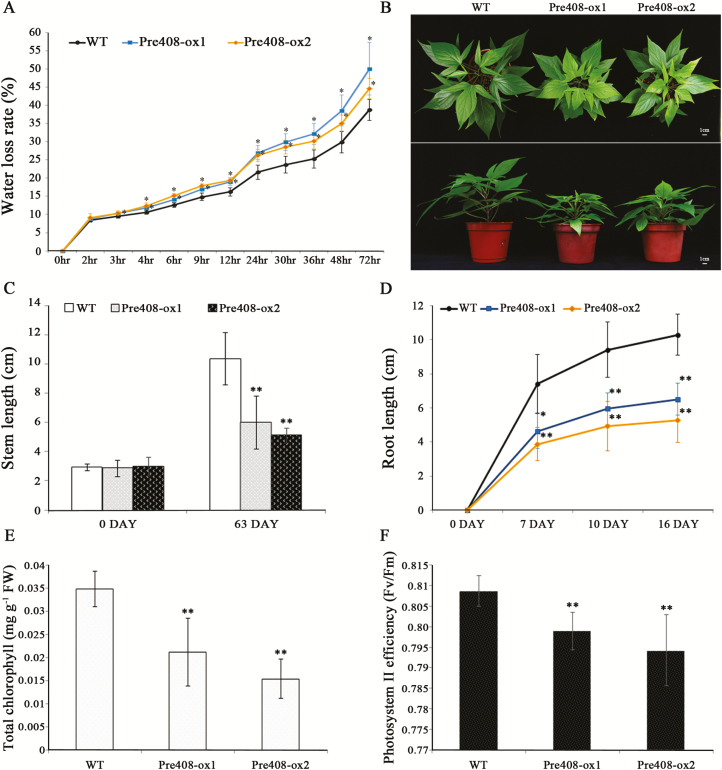
The phenotypes of miR408-overexpressing and wild-type (WT) sweet potato. (A) Water loss rates of WT and miR408-overexpressing (Pre408-ox1 and Pre408-ox2) plants. The water loss rates of the detached sweet potato leaves are shown. (B) The phenotypes of WT and miR408-overexpressing transgenic plants. Plants were grown for 6 weeks under a 16 h light/8 h dark photoperiod before photography. The stem lengths (C), root lengths (D), total chlorophyll contents (E), and PSII efﬁciencies (F) of WT and miR408-overexpressing sweet potato were measured. Data are presented as means ±SD (n≥6). The asterisk represents a significant difference between WT and miR408-ox plants by Student’s t-test (*P<0.05; **P<0.01).